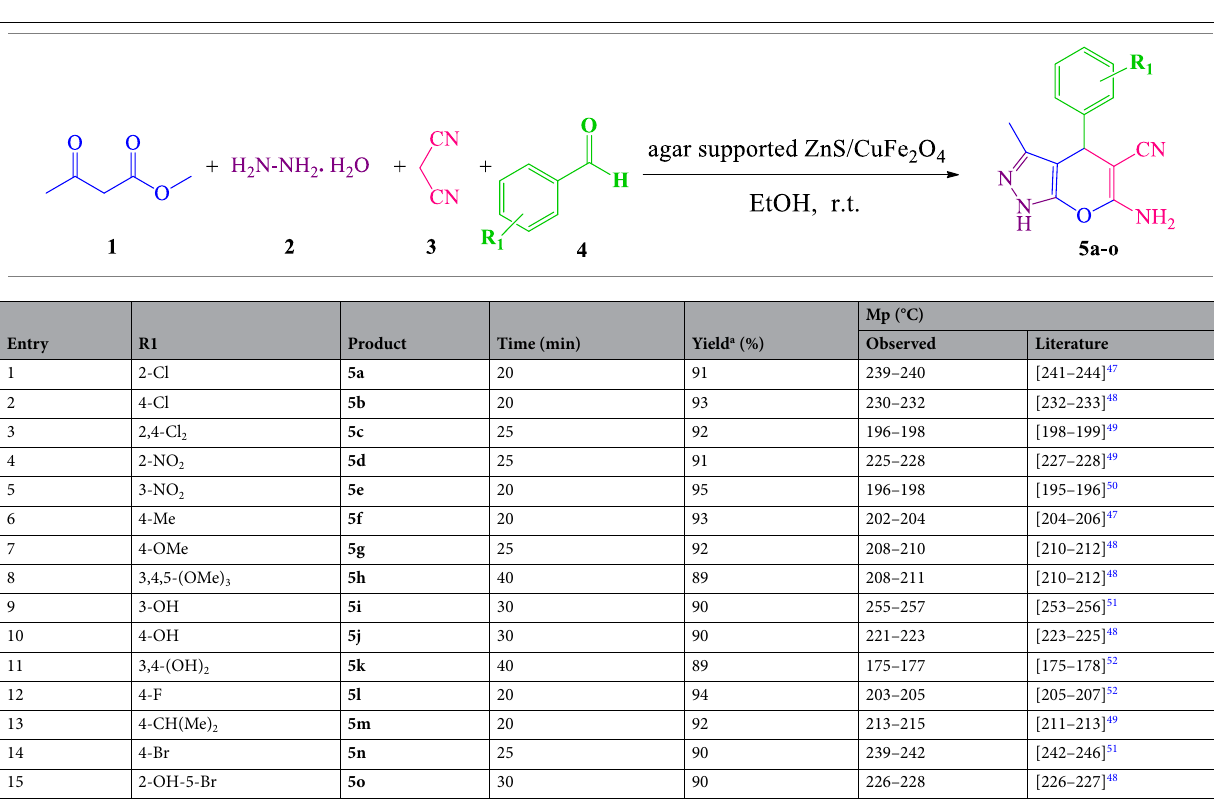
Table 2. The synthesis of different dihydropyrano[2,3-c]pyrazole derivatives under optimized conditions by utilizing agar supported ZnS/CuFe 2 O 4 catalyst. a The yields relate to the isolated